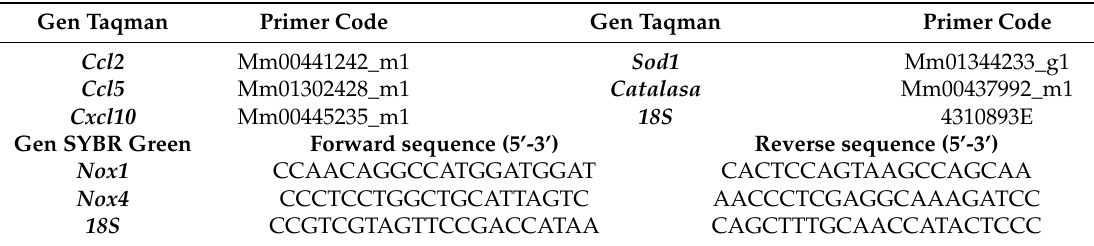
Table 1. Primers used in